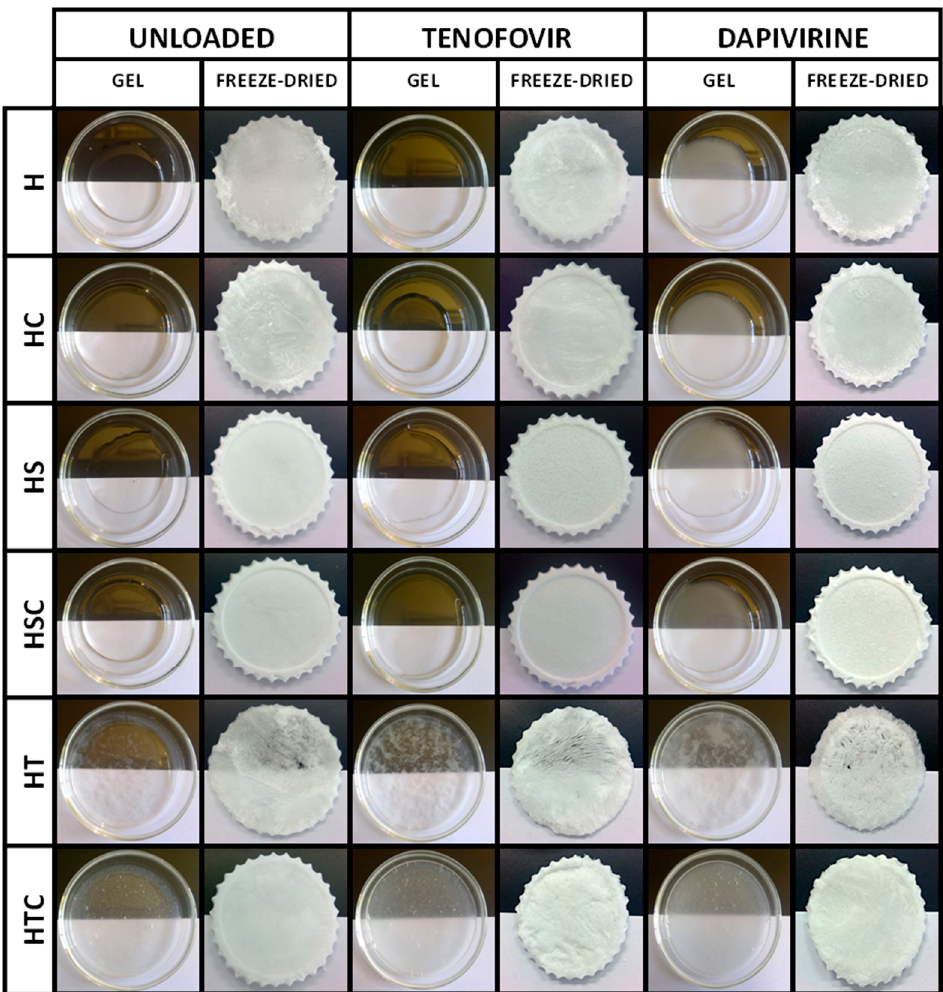
Figure 1. Appearance of each batch of fresh and freeze-dried gels.